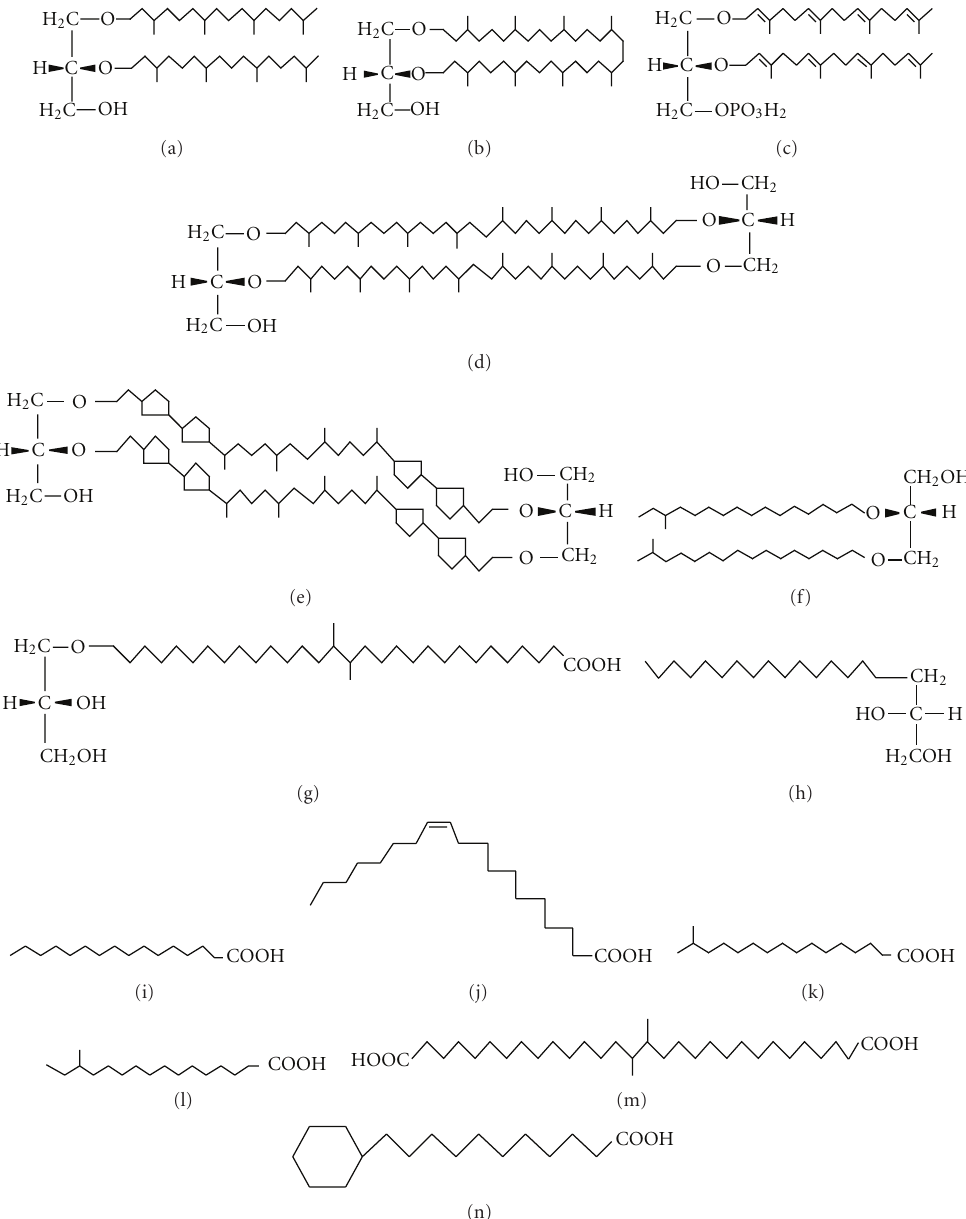
Figure 1: Structures of thermophilic lipid candidates (a) diphytanylglycerol (archaeol: archaeal diether lipid); (b) cyclic archaeol; (c) digeranylgeranylglycerophosphate (DGGGP); (d) caldarchaeol (archaeal tetraether lipid); (e) cyclopentane-containing caldarchaeol; (f) bacterial dither lipids; (g) 15,16-dimethyl-30-glyceryloxytriacontanoic acid; (h) 1,2-di-hydroxynonadecane (long-chain diol lipid); (i) palmitic acid (saturated straight chain fatty acid); (j) cis -vaccenic acid (monounsaturated straight chain fatty acid); (k) iso-C17 fatty acid; (l) anteiso-C17 fatty acid; (m) 15,16-dimethyltriacontandioic acid (diabolic acid); (n) 11-cyclohexylundecanoic acid. (a)–(e) Archaeal lipids; (f)–(n) bacterial